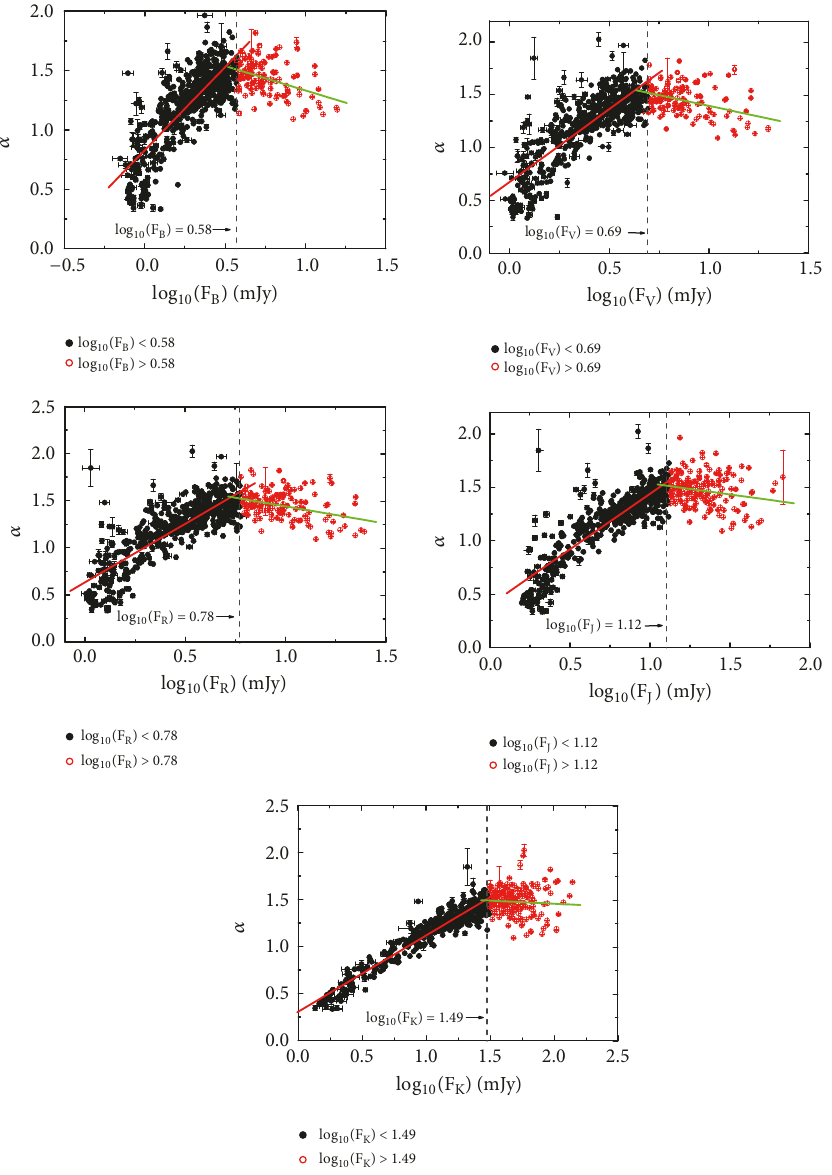
Figure 6: Relations between the logarithmic flux densities (log (𝐹 ] ) ) and optical spectral indices ( 𝛼 ). The black dots and red dots stand for the different regions, with the blue line separating